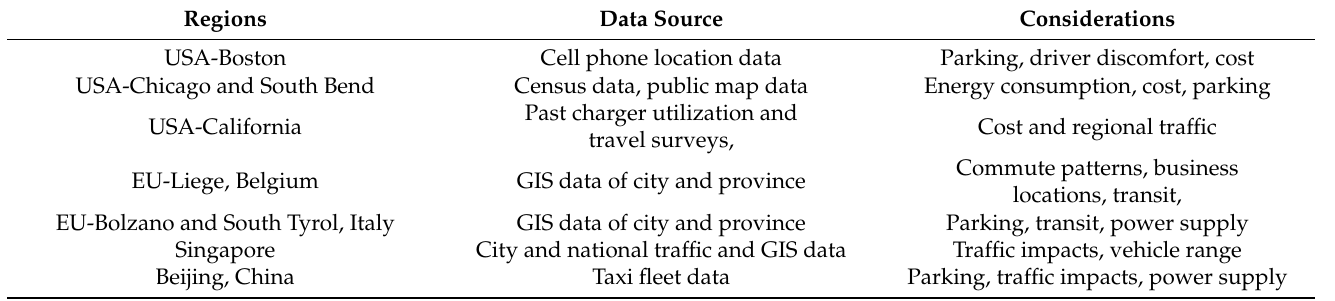
Table 10. Summary of case studies on charging station placement [103].